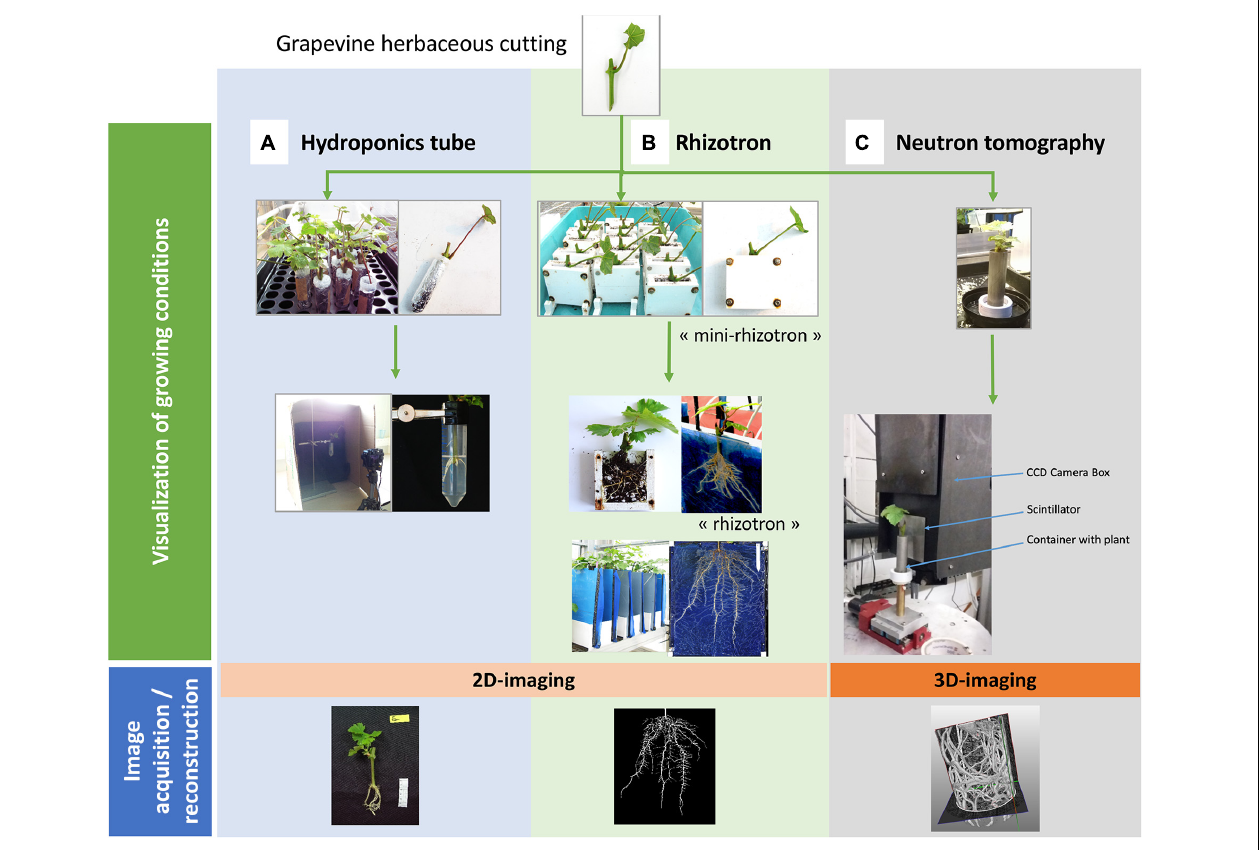
FIGURE 1 | Overview of the different devices, growing conditions and image acquisition / analysis process. Grapevine herbaceous cuttings (cv. Marselan) were placed in three devices (top line: “Visualization of growing conditions”): (A) hydroponics tubes, (B) rhizotrons, and (C) aluminum cylinder for neutron tomography. They were then grown in greenhouse conditions and, depending on the method, some RSA parameters could be phenotyped. Quantitative parameters (i.e., projected root area) could be measured by image reconstruction and analysis (bottom line: “image